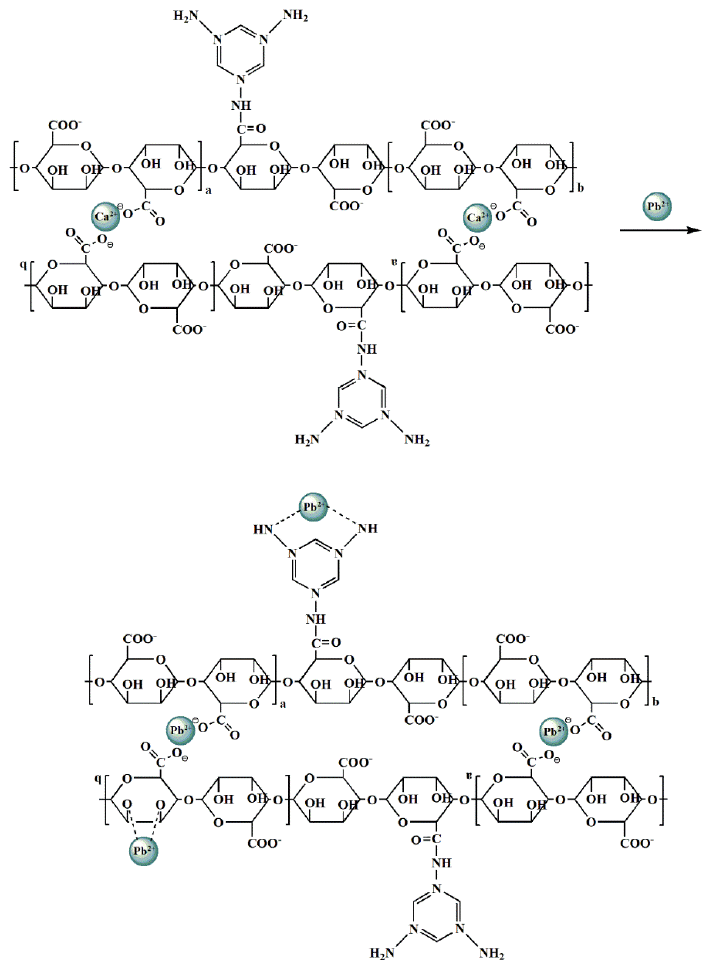
Figure 8. Possible binding mechanisms of Alg-Mel with Pb 2+ .